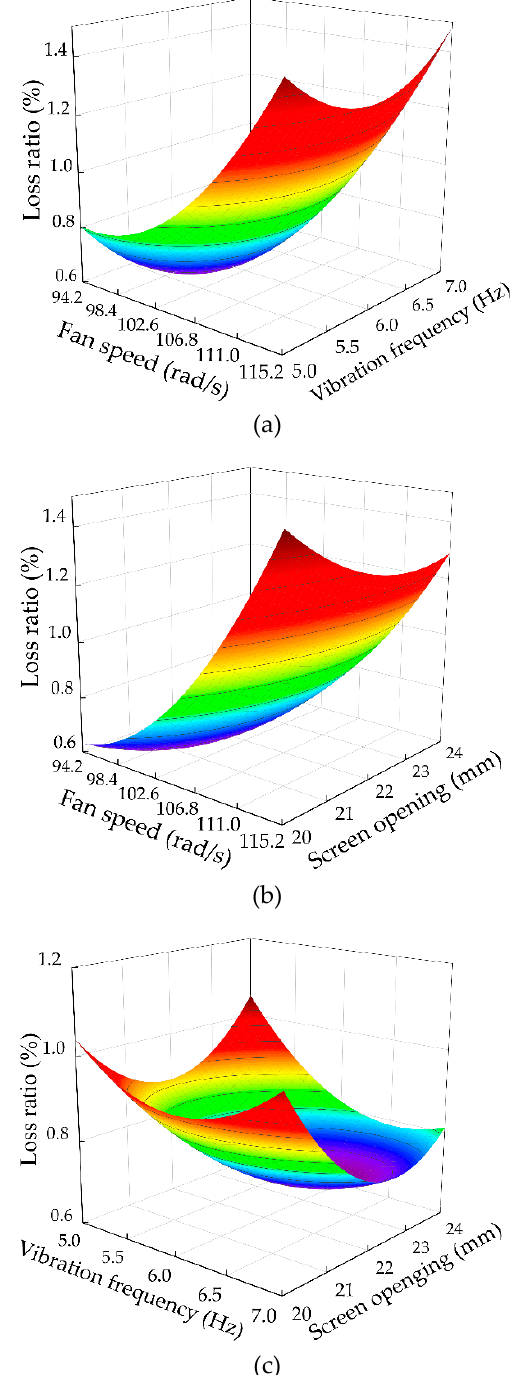
Figure 10. Response surface plots for interaction between the pairs ( a ) FS–VF, ( b ) FS–SO, and ( c ) VF–SO.